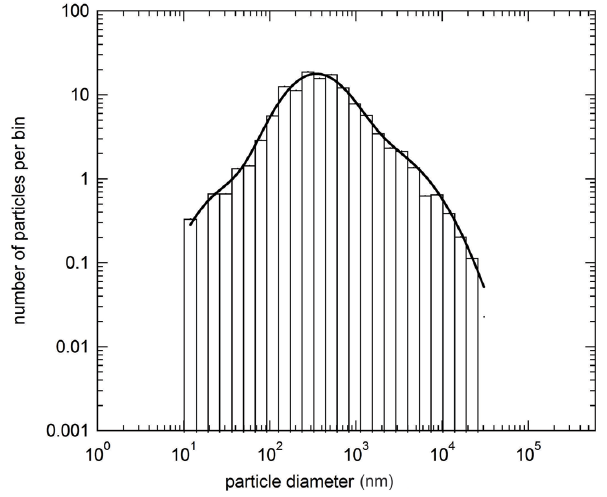
Fig. 2. Tri-modal lognormal distribution: best fit to the Hoggar sam- ple size